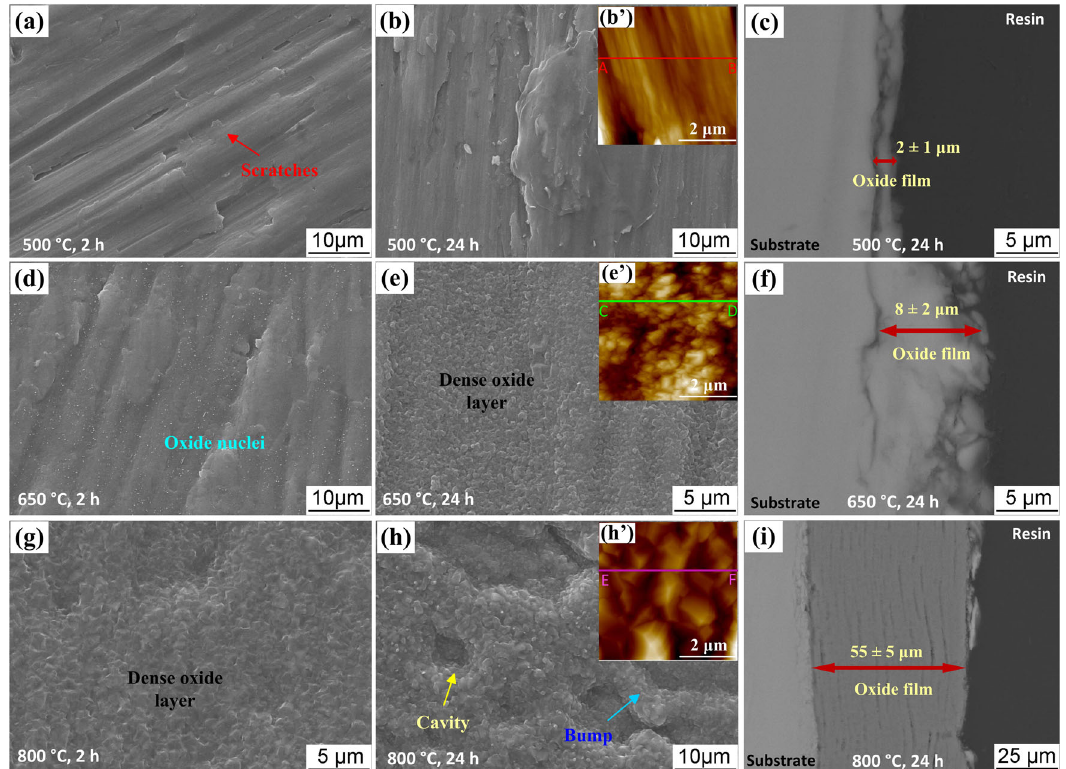
Fig. 1 Microstructure of the thermal oxide fi lm formed on pure Ti. Surface morphologies ( a , b , d , e , g , h ), topographies ( b' , e' , h '), and the cross-sectional morphologies ( c , f , i ) at 500 °C ( a – c ), 650 °C ( d – f ), and 800 °C ( g – i ) for 2 ( a , d , g ) and 24 h ( b , c , e , f , h , i ). The height ranges in b' , h' , and e' are − 226 ~ 189 nm, − 275 ~ 255 nm, and − 399 ~ 499 nm,